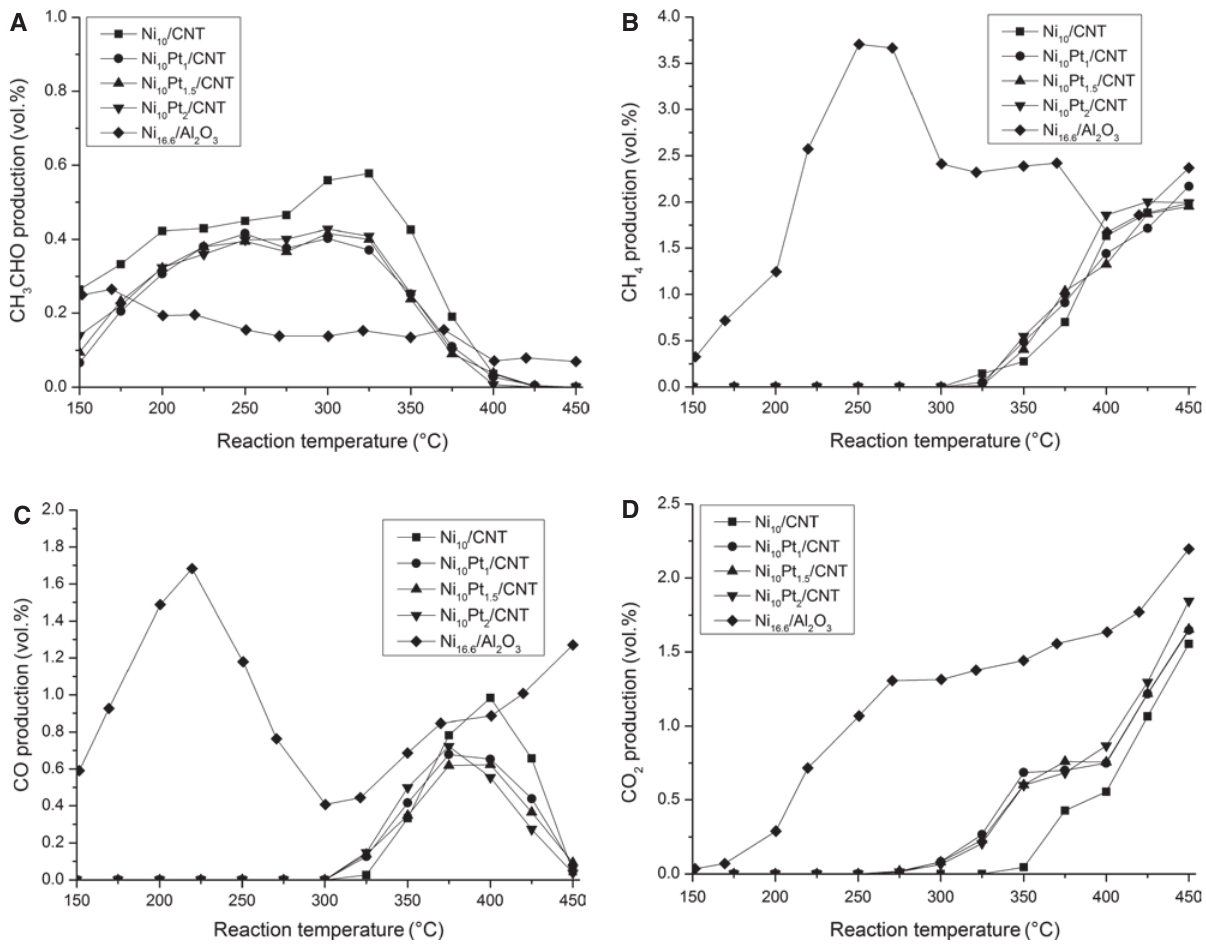
CHO, (B) CH , (C) CO and (D) CO as a function of reaction temperature over Ni 3 4 2